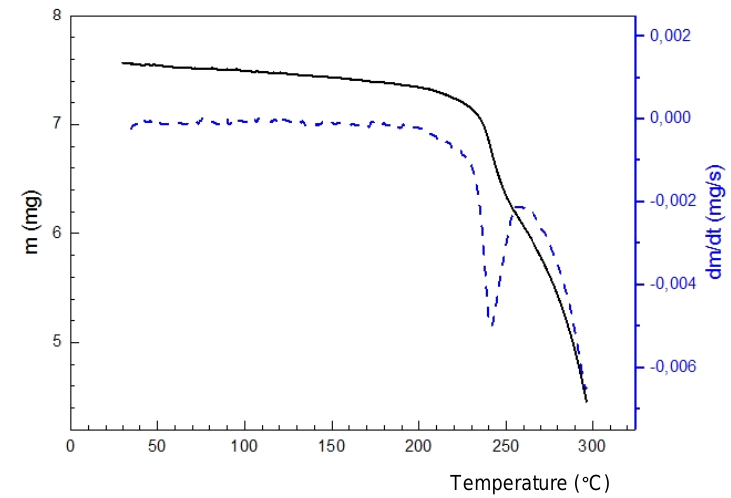
Figure 7. Derivatograms of acid monohydrate 4 : thermogravimetric curve (black); differential thermogravimetric curve (blue). Sample weight 7.57 mg.